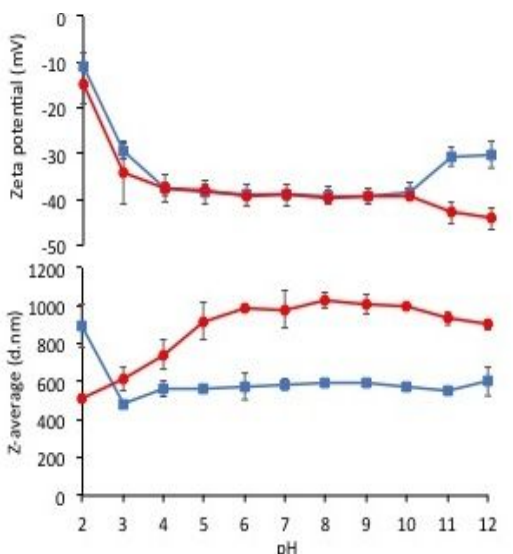
Figure 5. Zeta potential (upper panel) and Z-average (lower panel) measurements of PGA performed at different pH values. Undialyzed ( (cid:4) ) and dialyzed ( • ) PGA samples containing 1.0 mg protein dissolved in 1.0 mL of distilled water adjusted at pH 12. All the results are reported as mean ± standard deviation. Further experimental details are given in the text.